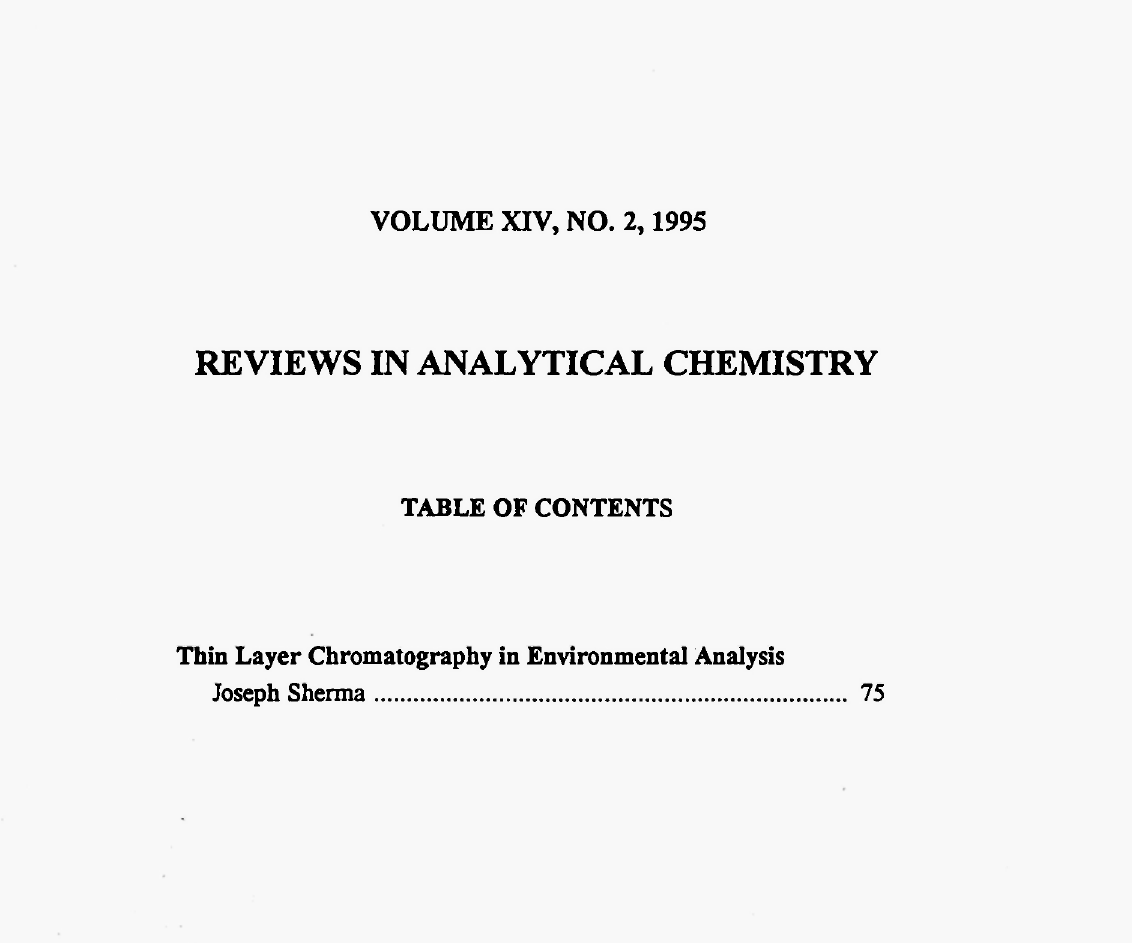
Thin Layer Chromatography in Environmental